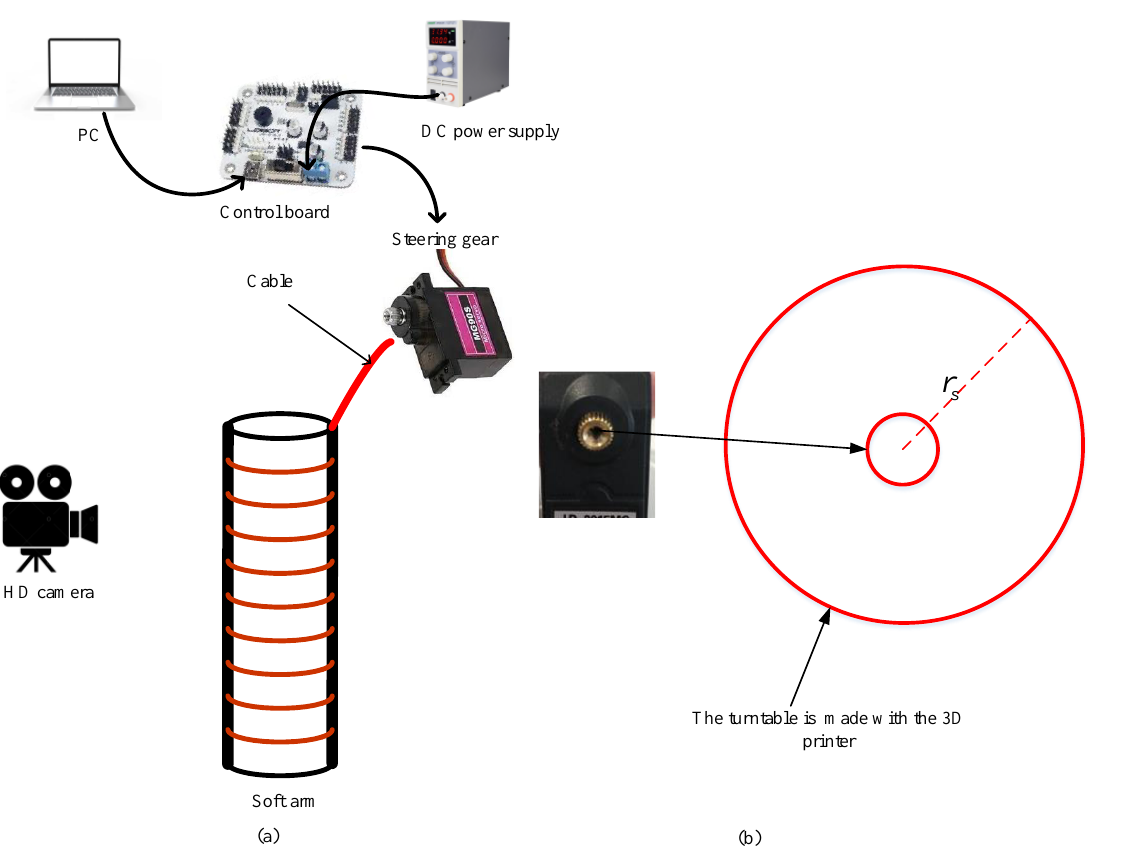
Figure 5. ( a ) Diagram of cable drive soft arm; ( b ) Turntable made by the 3D printer used to fix the cable on the steering gear.